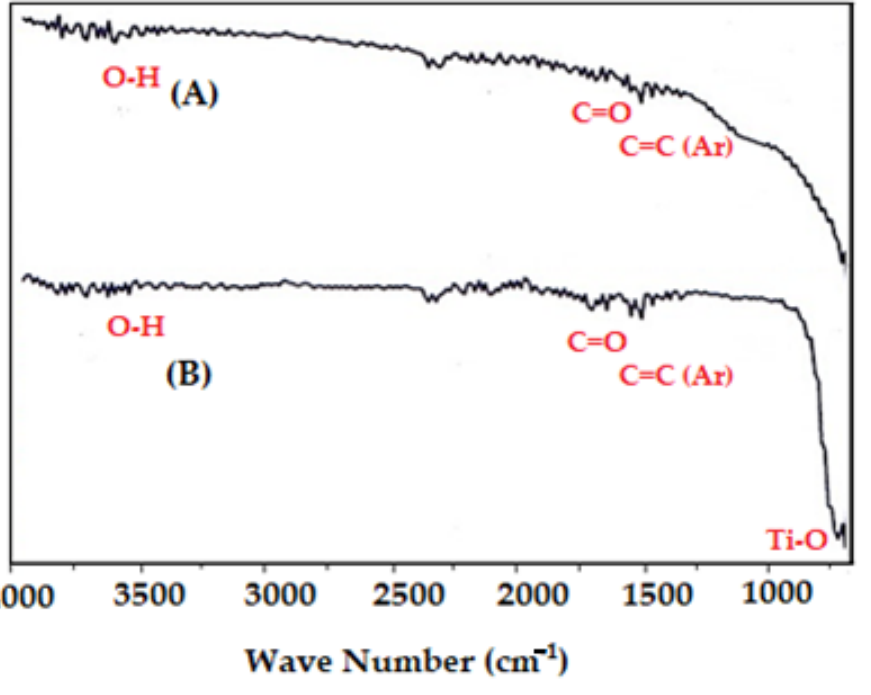
Figure 1. FTIR spectra of (A) AC and (B) TiO 2 /AC.